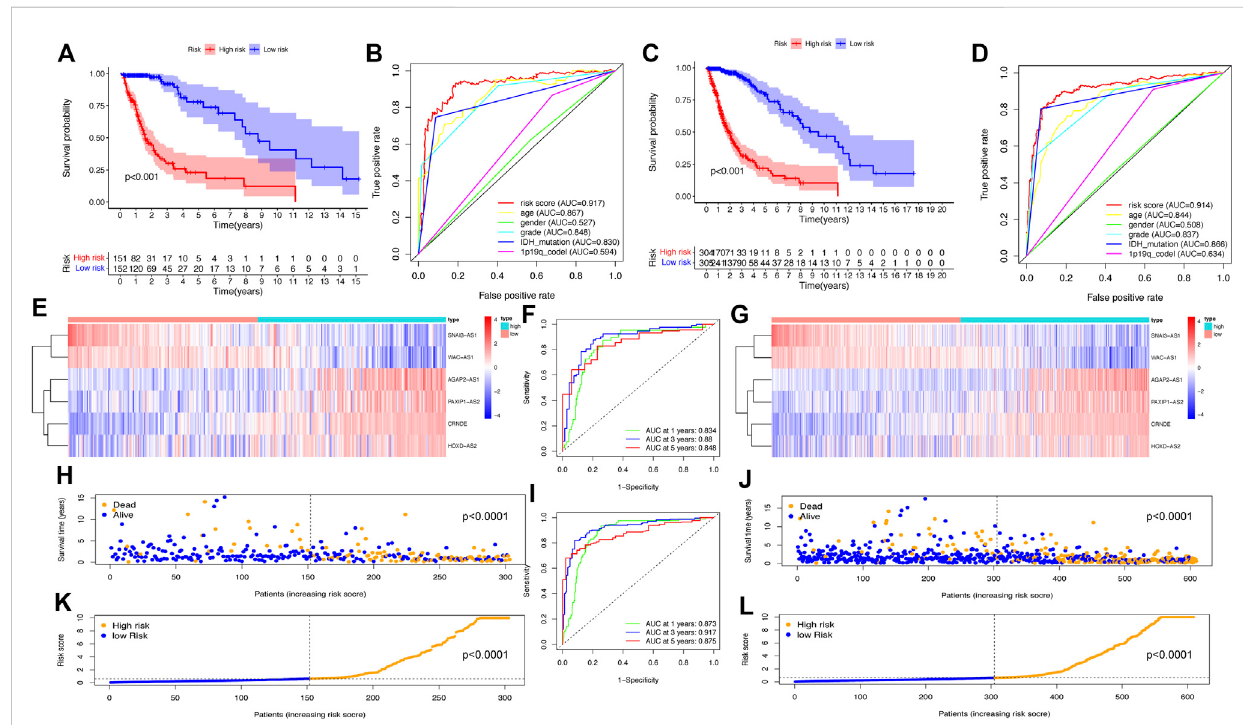
FIGURE 4 Validation of the SRlncRNA prognostic signature in the testing cohort and the whole cohort. K-M curves show that the higher risk group had worse OS in the testing cohort (A) and whole cohort (C) . The ROC curves for the prognostic features in the testing cohort (B) and whole cohort (D) suggest the highest AUC values for the risk score. Heatmap of 9 SRlncRNAs expression pro fi les show SRlncRNA expression in the high-risk group and the low-risk group in the testing cohort (E) and the whole cohort (G) . ROC curves at 1, 3 and 5 years in both the testing cohort (F) and the whole cohort (I) show signi fi cant sensitivity. Scatter plots show the correlation between the survival status and risk scores of high- and low-risk glioma patients in the testing cohort (H) andthewholecohort (J) .Riskdistributionplotsshowthedistributionofhigh-riskandlow-risk gliomapatientsinthetestingcohort (K) andthe whole cohort (L)